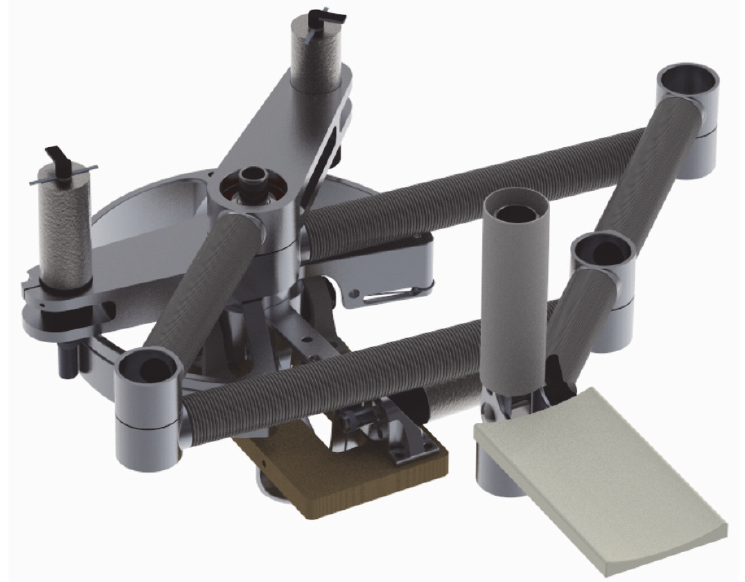
Figure 7. HomeRehab robotic tele-rehabilitation